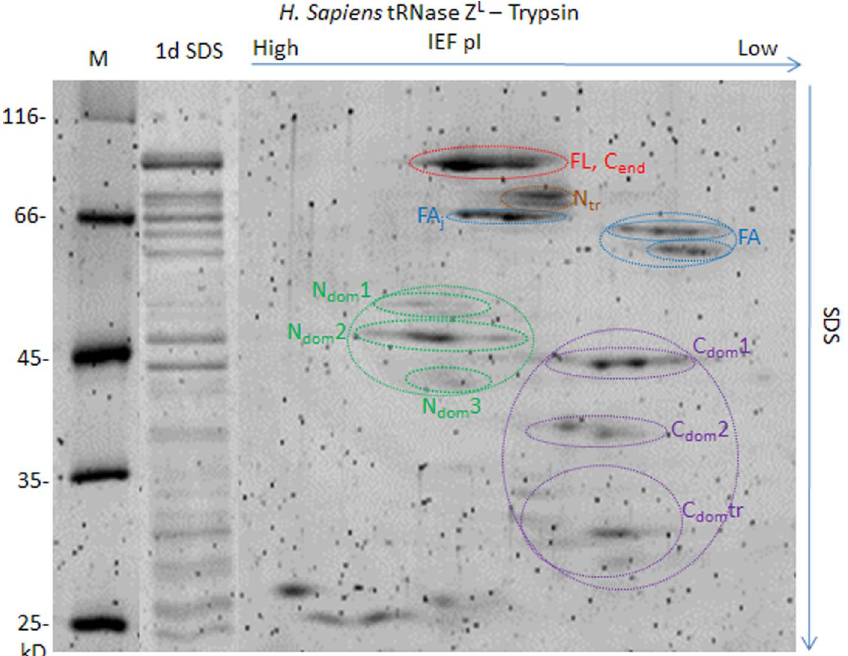
Figure 9. Two dimensional gel electrophoresis of H.sapiens tRNase Z L -trypsin polypeptides. A ten min. digest like those illustrated in Figure 5 was electrophoresed on a first dimension isoelectric focusing tube gel. The second dimension SDS-PAGE was as in Figure 5.